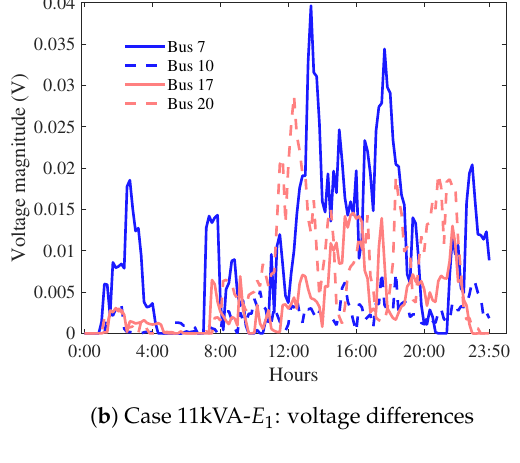
( b ) Case 11kVA- E 1 : voltage differences